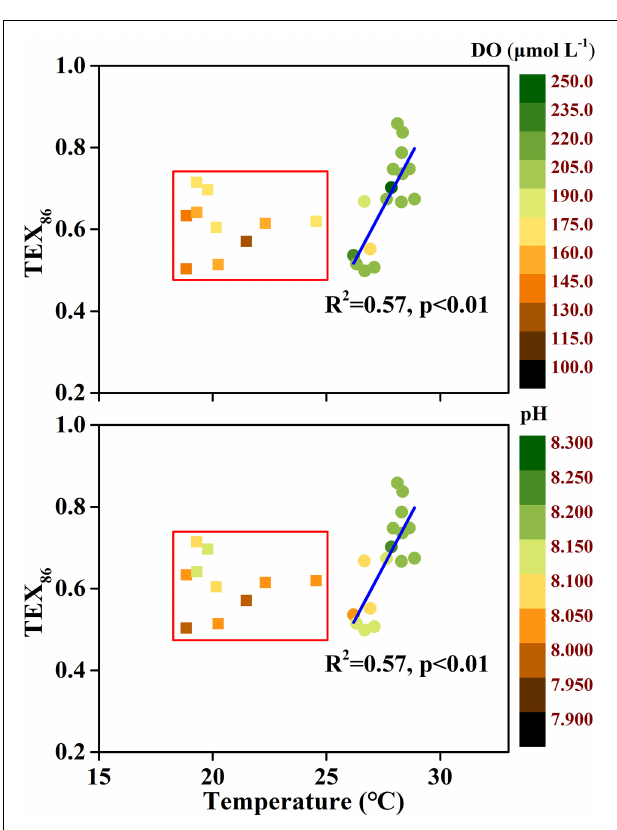
FIGURE 9 | Relationship between TEX 86 and temperature in the East China Sea (ECS) during summer. Inside the red rectangles are samples characterized by the relatively low dissolved oxygen (DO) and pH. The temperature is derived from in situ CTD